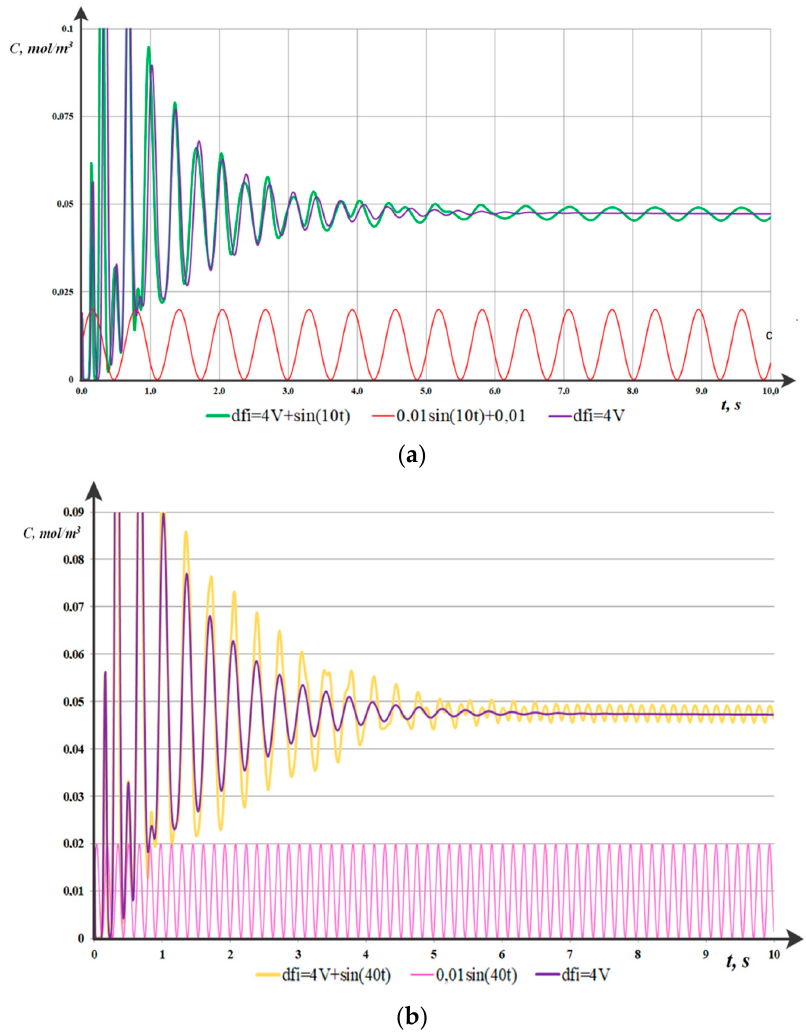
Figure 8. ( a ) Periodic change in the total concentration (self-oscillations) on the cathode surface at a potential jump of 4 V (purple), the same self-oscillations with forcing oscillations ∆ ϕ = 4 + sin ( 10 t ) (green) and periodic forcing oscillations 0.01sin ( 10 t ) (red). ( b ) Periodic change in the total concentration (self-oscillations) on the surface of the cathode with the potential jump of 4 V (purple), as well as the same oscillations with force fluctuations ∆ ϕ = 4 + sin ( 40 t ) (yellow) and periodic forcing vibrations 0.01sin(40 ) t (pink).